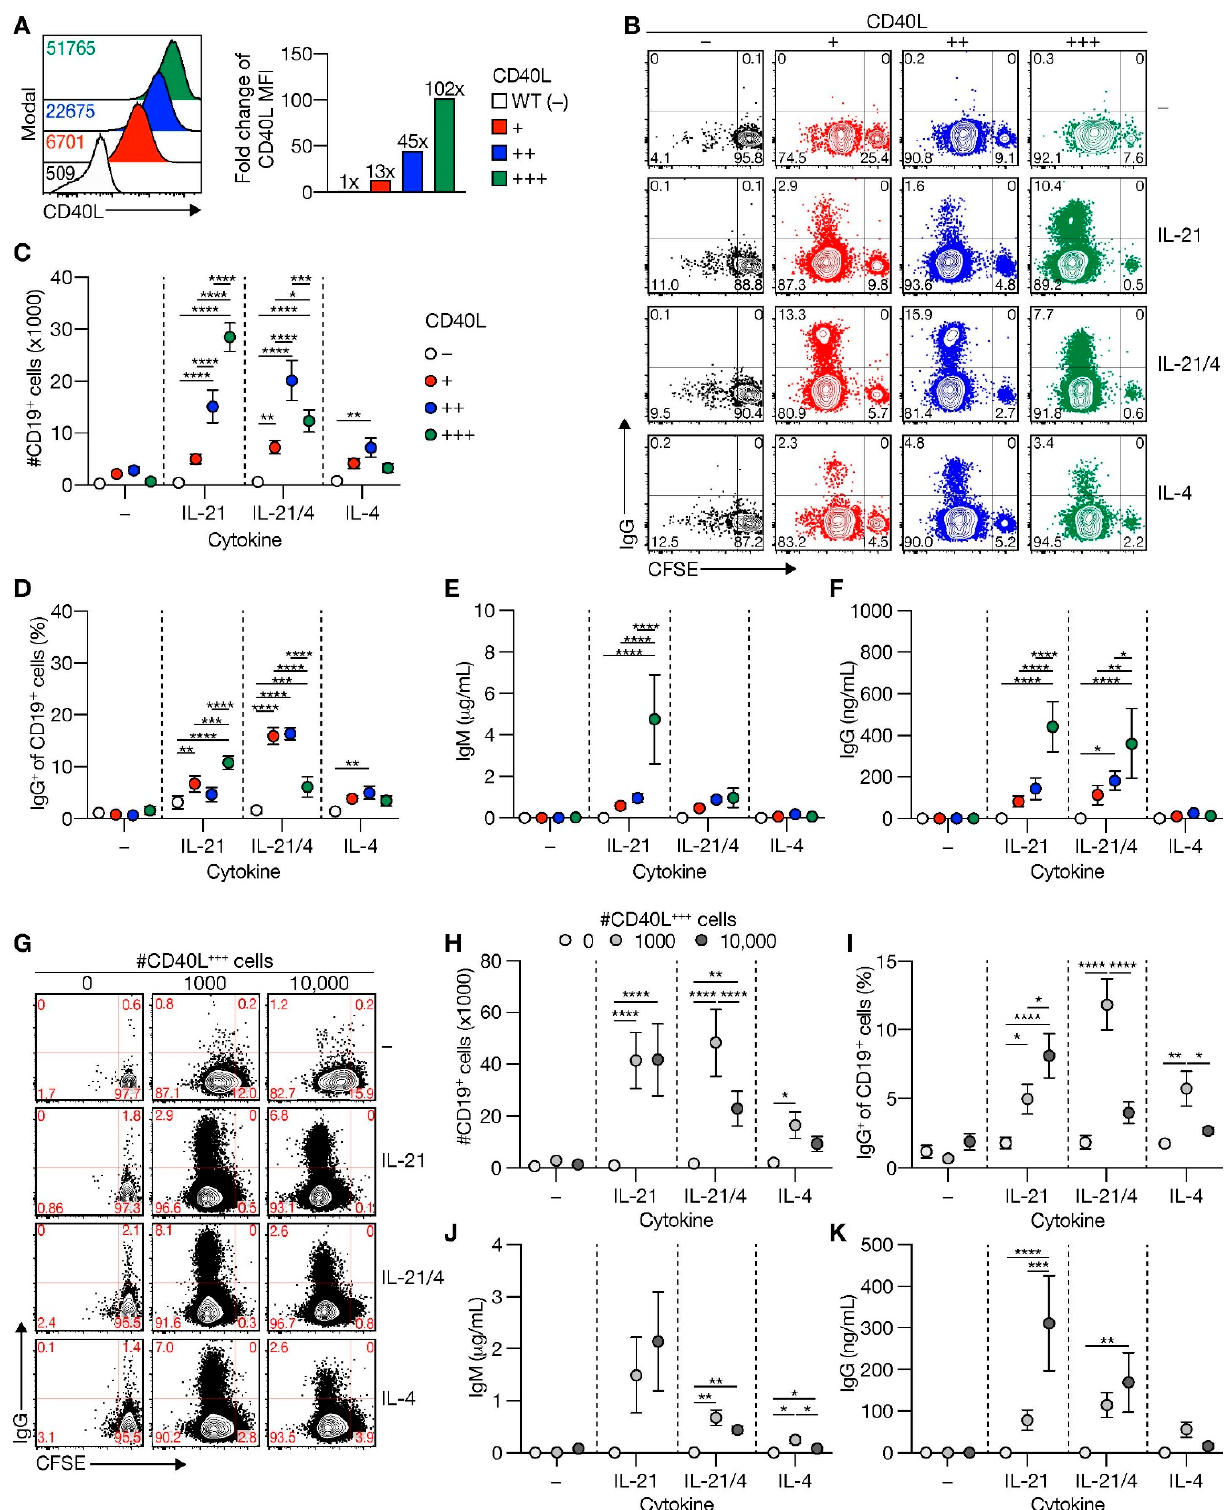
Figure 1. Level of CD40L expression and number of CD40L feeder cells supports human naive B-cell expansion and IgG class switching. ( A ) Representative histograms (left) of human CD40L expression stably transfected 3T3 fibroblasts expressing various amounts of human CD40L (+, ++ or +++) compared to non-transfected 3T3 cells (WT; − ). Numbers indicate the mean fluorescence intensity (MFI) of CD40L expression. Fold changes compared to WT controls of CD40L MFI are shown in the right panel (data shown represent three separate experiments). ( B – D ) Human CFSE-labeled naive B-cells were cultured on 3T3 cells expressing varying levels of CD40L with or without IL-21 and/or IL-4 for 6 days and analyzed